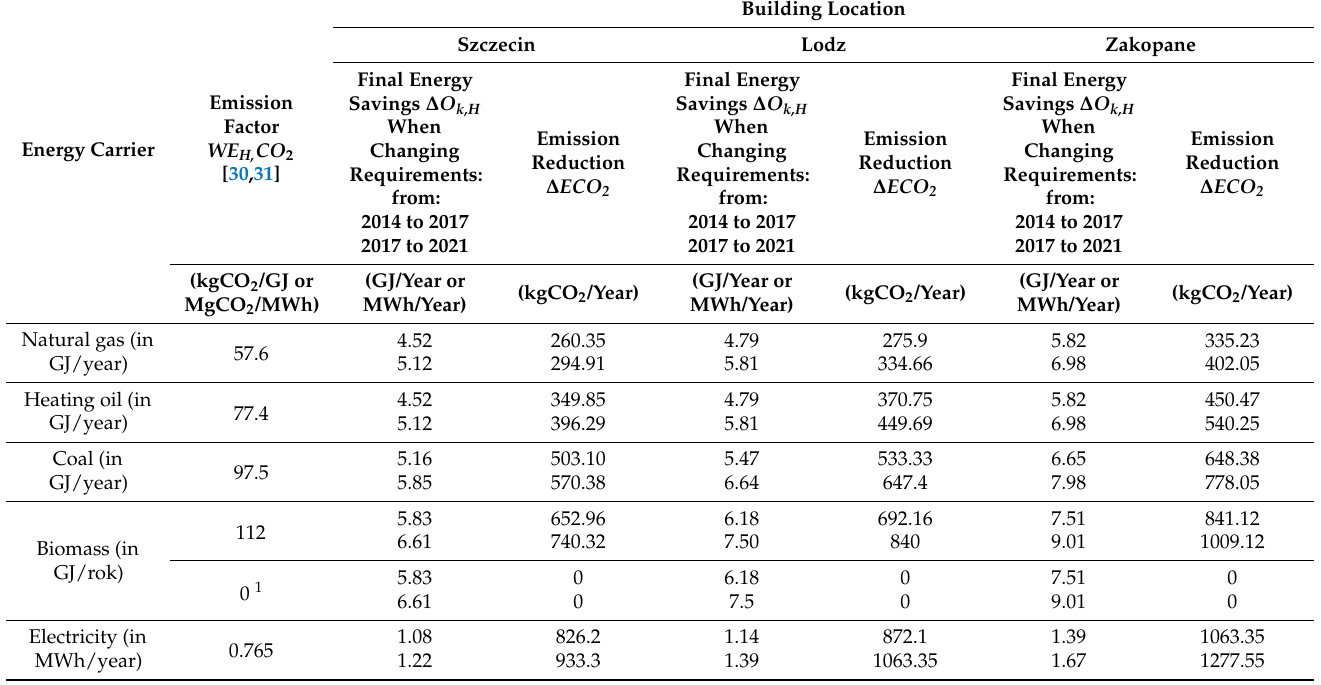
Table 9. Reduction of CO 2 emissions in the analyzed variants.